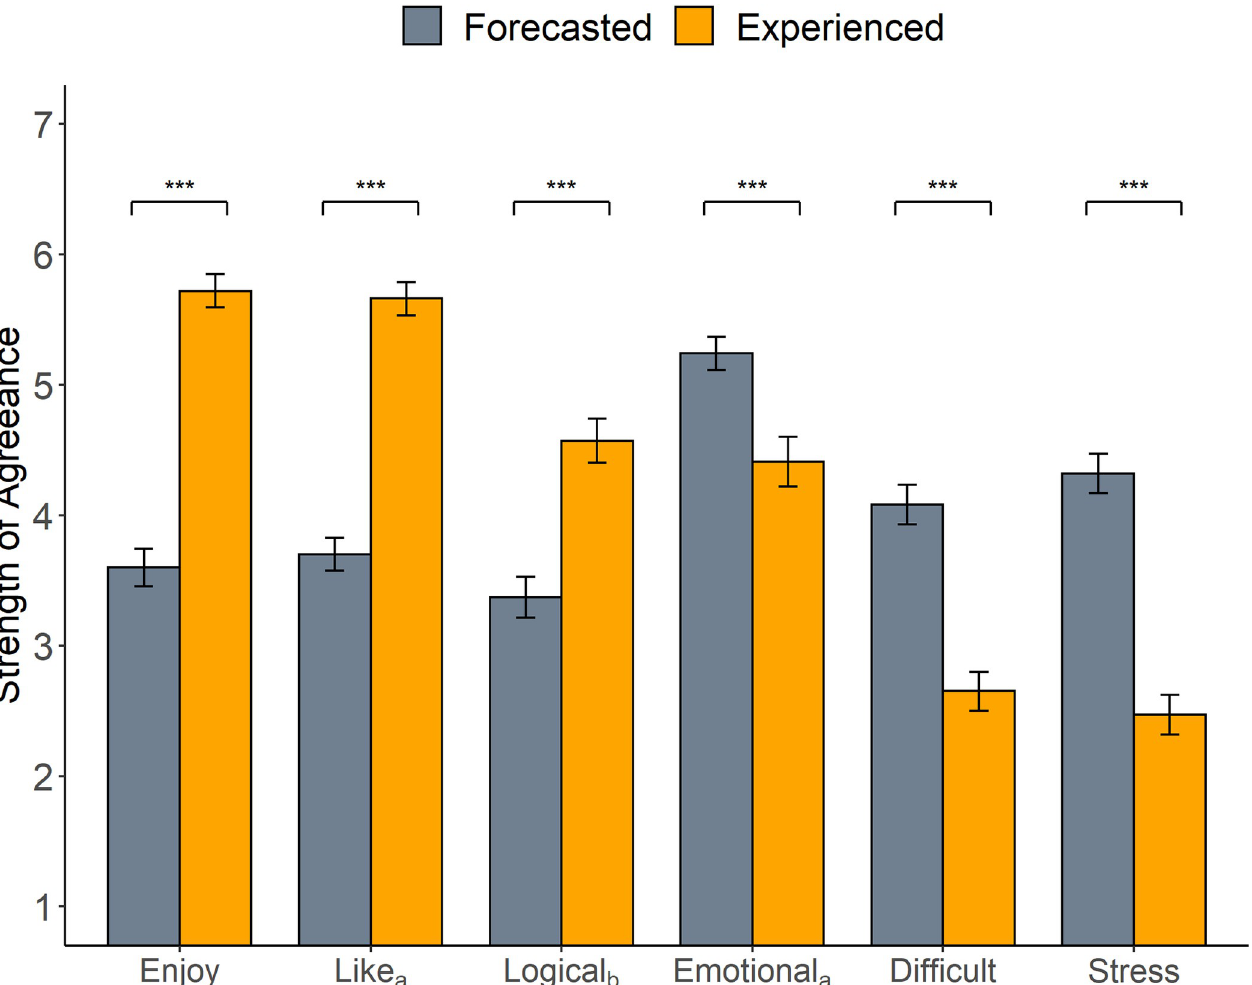
Fig 1. Difference in CIC forecasts vs experience. Note . Difference in what participants ( n = 120) forecasted about the CIC beforehand, compared to what they actually experienced during the CIC. Variables were measured on a 1 (strongly disagree) to 7 (strongly agree) scale. For example, “I believe this interaction would be enjoyable” and “This interaction was enjoyable”. For exact wording of questions and additional statistics, see Table S2 in S1 Appendix. ��� p < .001, a Sample size is n = 106, b Sample size n =